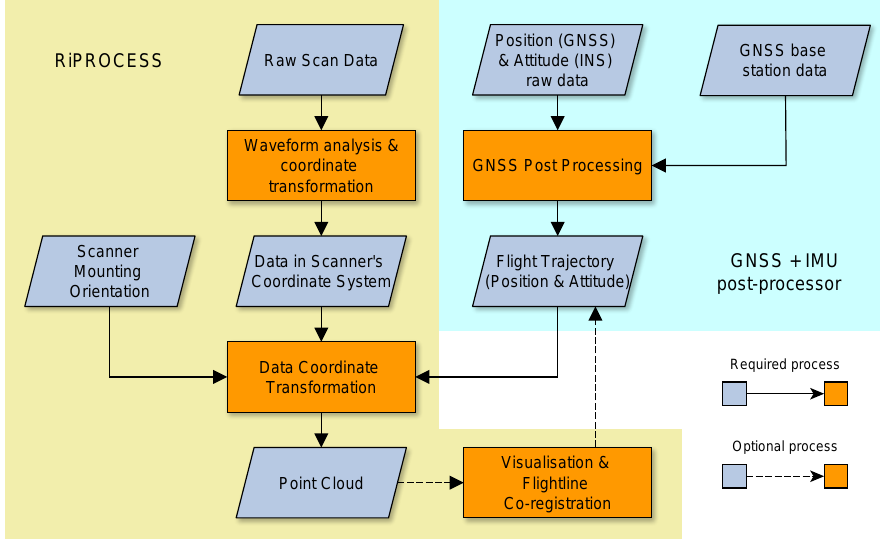
Figure 1. RiCOPTER processing flowchart (based on